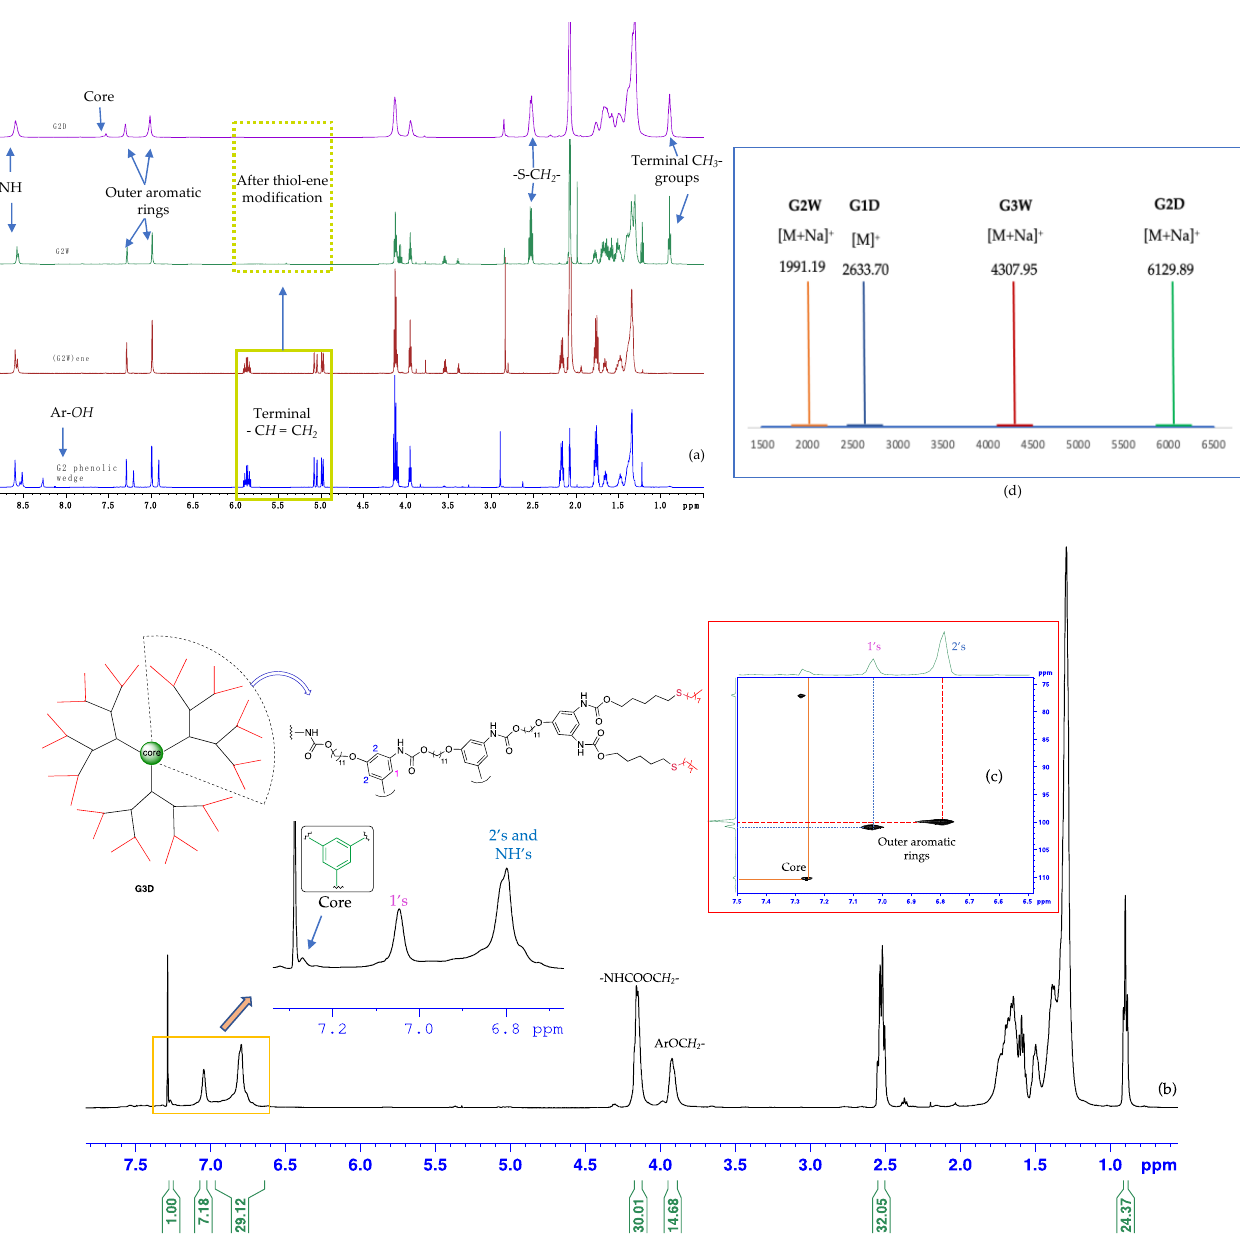
Figure 3. ( a ) Representative 1 H NMR spectra (stacked) showing the G2 phenolic wedge 9 , (G2W) ene , G2W , and G2D, respectively, from bottom to top, ( b ) 1 H NMR spectrum of G3D : integrals in full spectrum show the one-third portion of this C 3 symmetric molecule, whereas the expanded region depicts aromatic protons of both core and peripheral groups, ( c ) a portion of HSQC of G3D showing heteronuclear 1 H- 13 C coupling at aromatic region, and ( d ) MALDI-TOF spectra of G1-G3 dendrons and dendrimers (NMR spectra were recorded in 500 MHz spectrometer at 298 K using CD 3 COCD 3 as deuterated solvent).